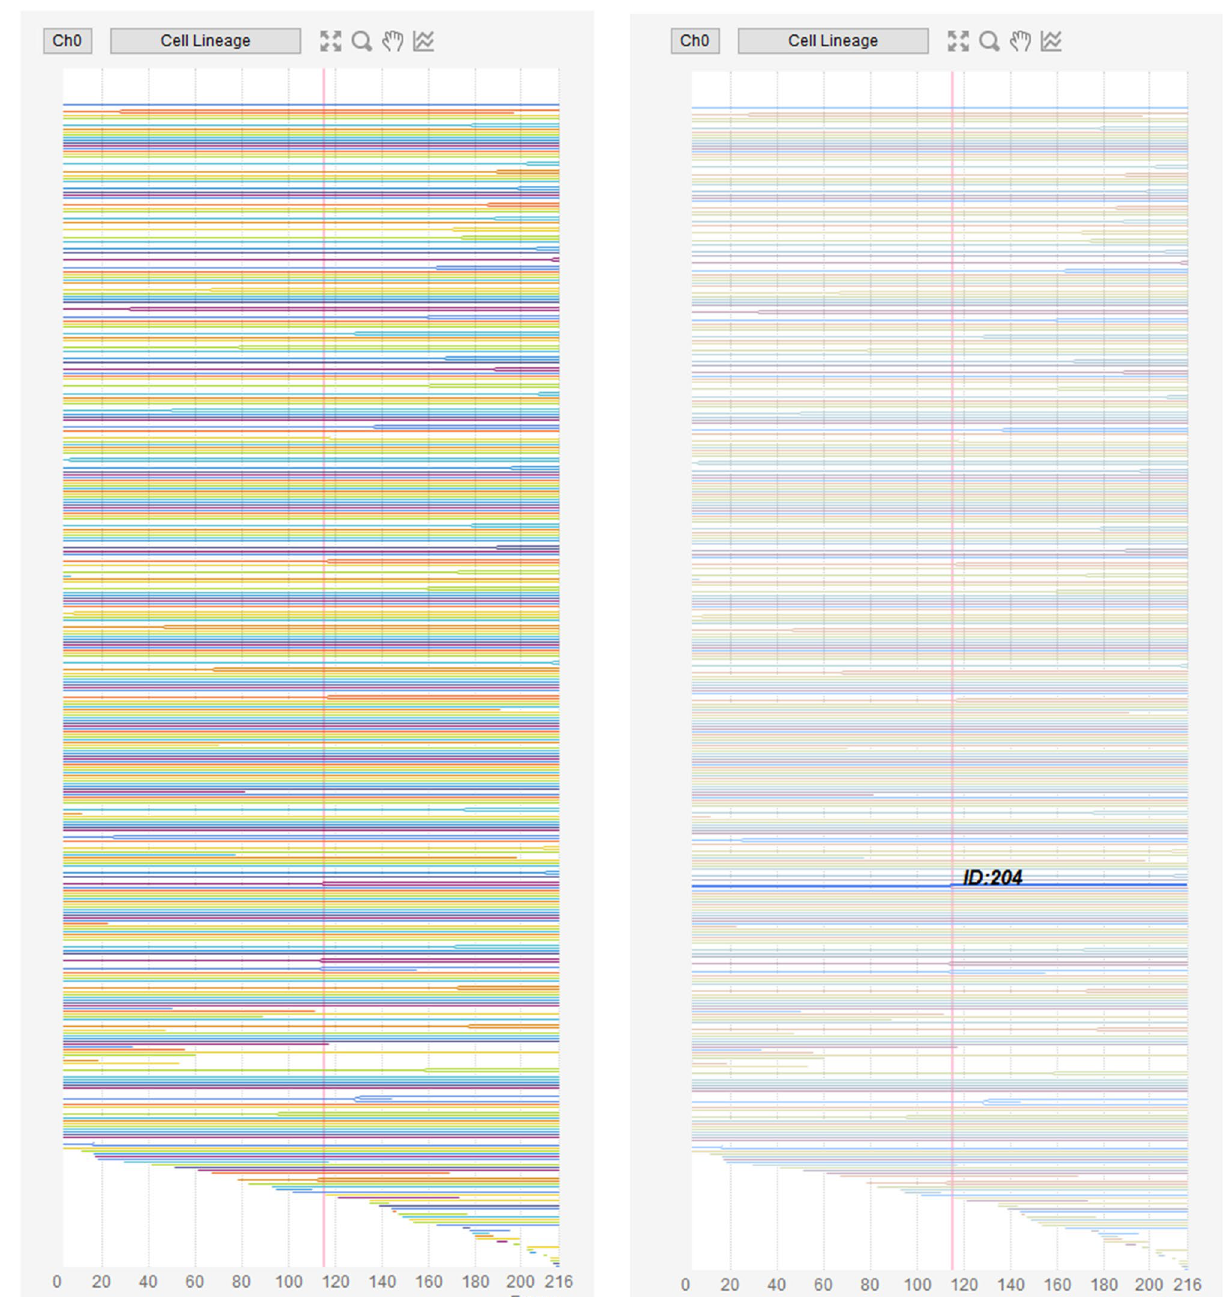
Figure 5. Cell lineage display. Cell lineage display of Case 1 [right: selected and highlighted lineage for a specific ROI (ID